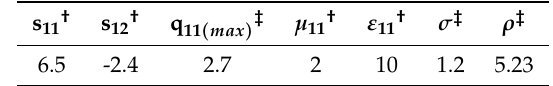
Table 3. Material coefficients for CoFe 1.75 Mn 0.25 O 4 at 25 ◦ C, including the compliances s 11 and s 12 , the maximum piezomagnetic coefficient q 11 ( max ) , the magnetic permeability µ 11 , the dielectric permittivity ε 11 , the electrical conductivity σ and the density ρ , in units of 10 − 12 m 2 /N, 10 − 6 m/kA, µ 0 (vacuum permeability), ε 0 (vacuum permittivity), 10 − 4 S/m and g/cm 3 ,